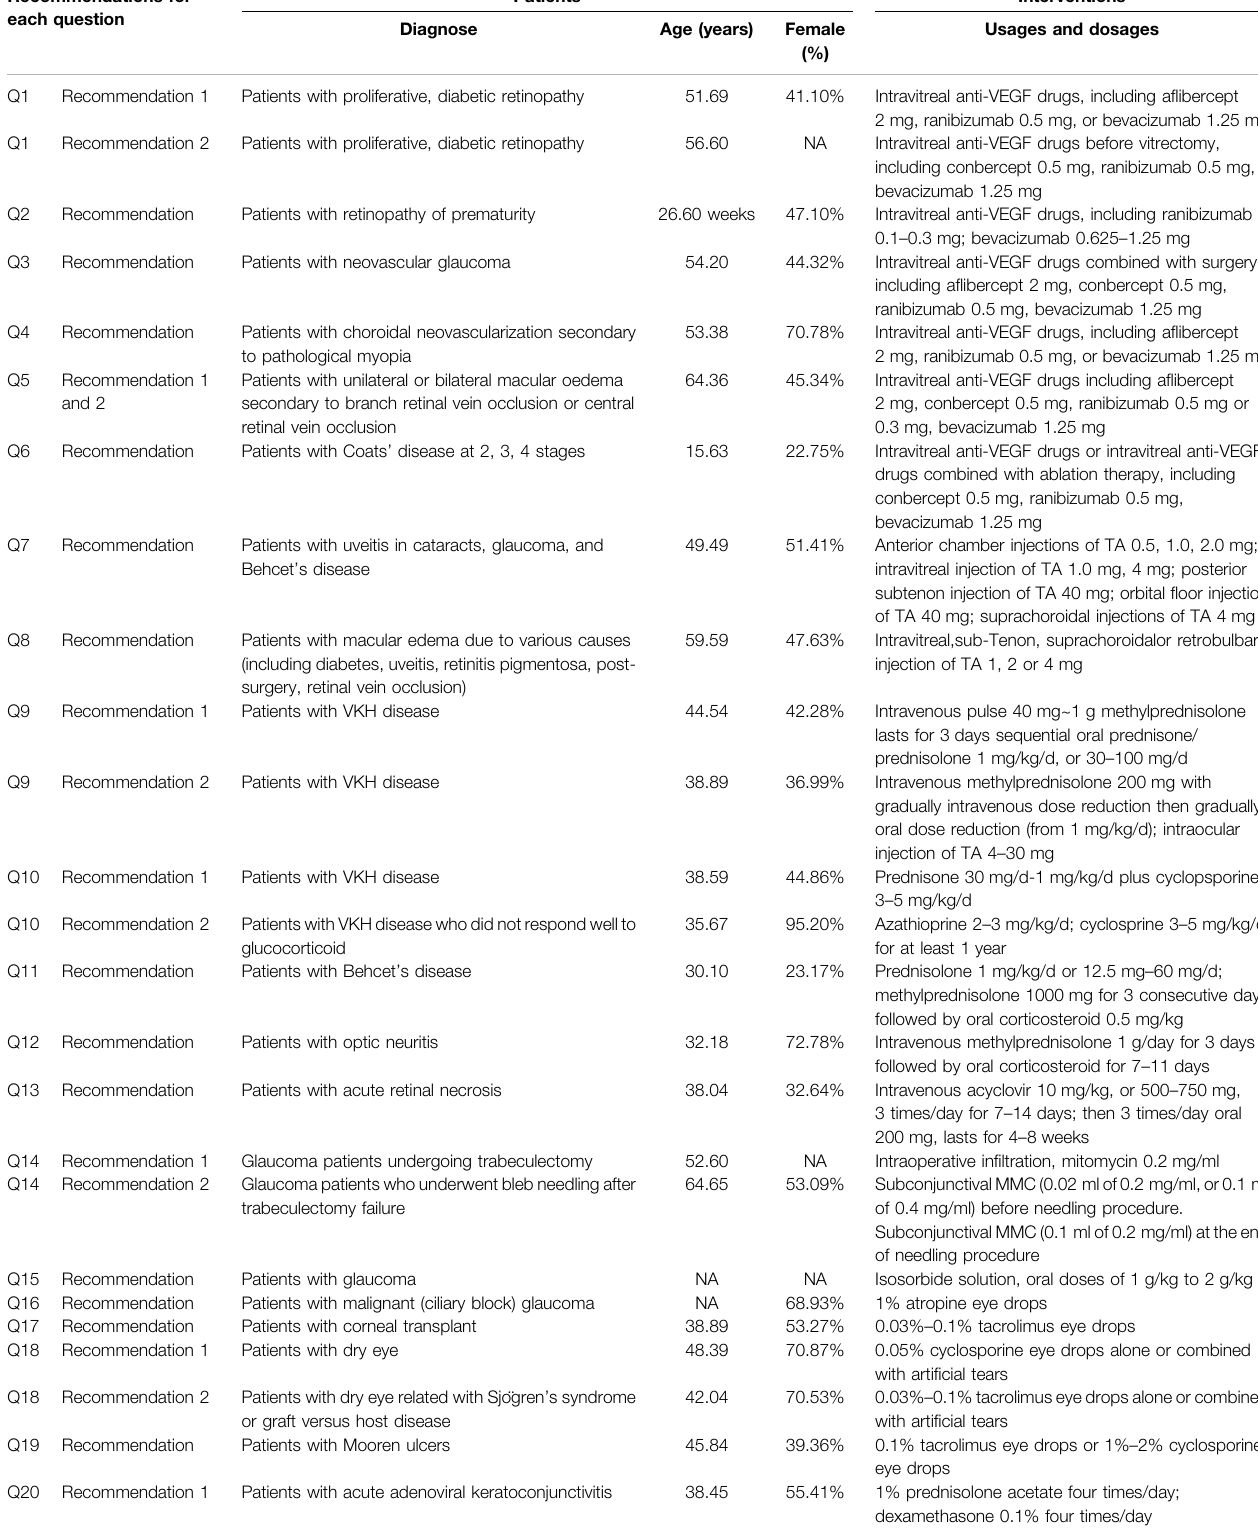
TABLE 1 | The characteristics of the systematic reviews included for recommendations